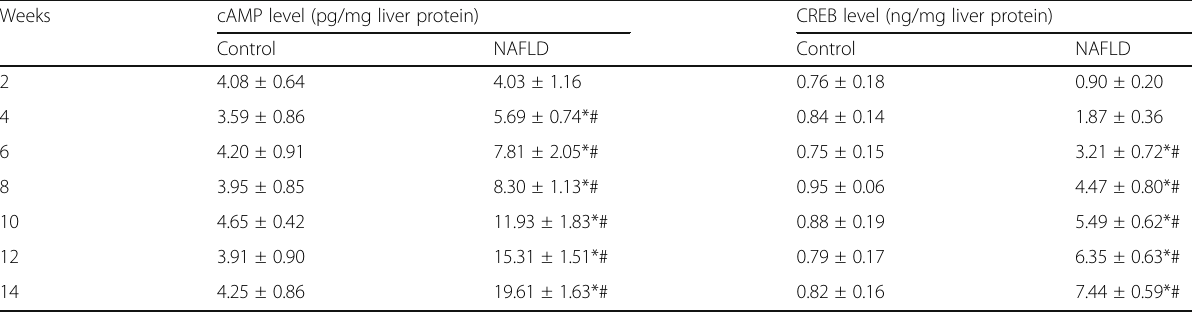
Table 5 The liver tissue cAMP and CREB levels in control and NAFLD rats